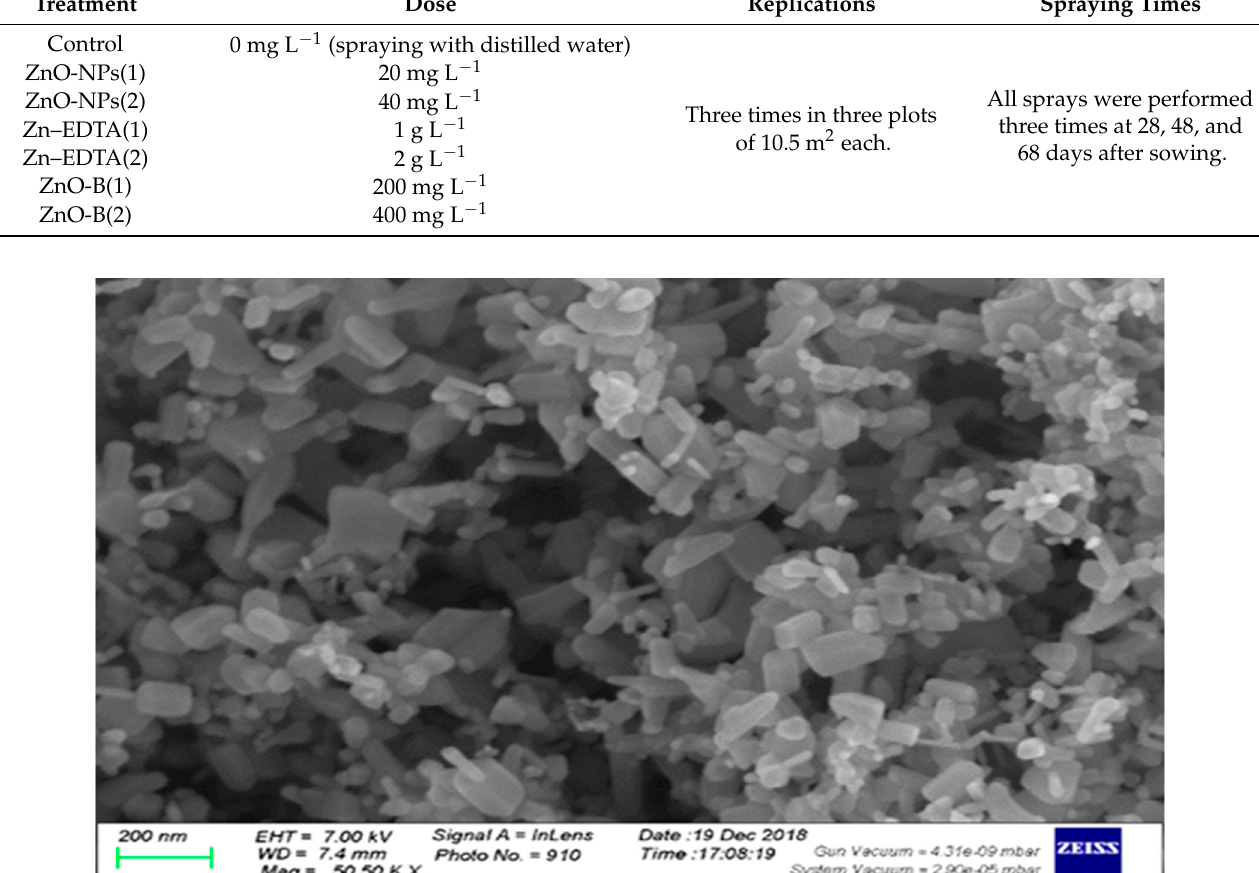
three times in three plots. There were four rows of 3.0 m length in each plot and 42–43